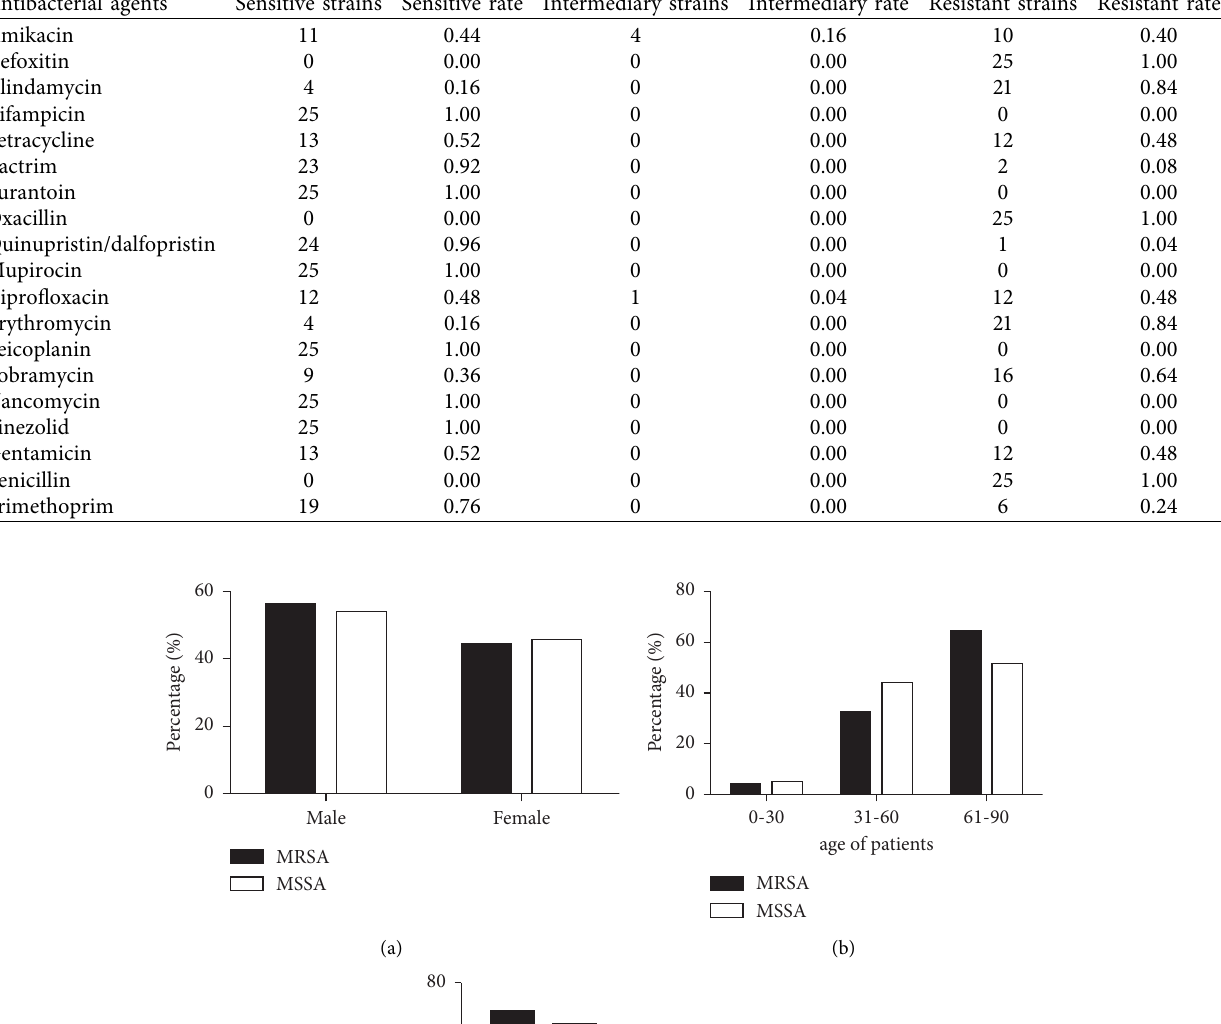
Table 2: Drug sensitivity of 25 strains of MRSA to antimicrobial agents.